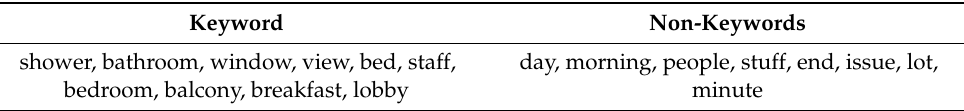
Table 1. Examples of keywords and non-keywords for hotel comments.